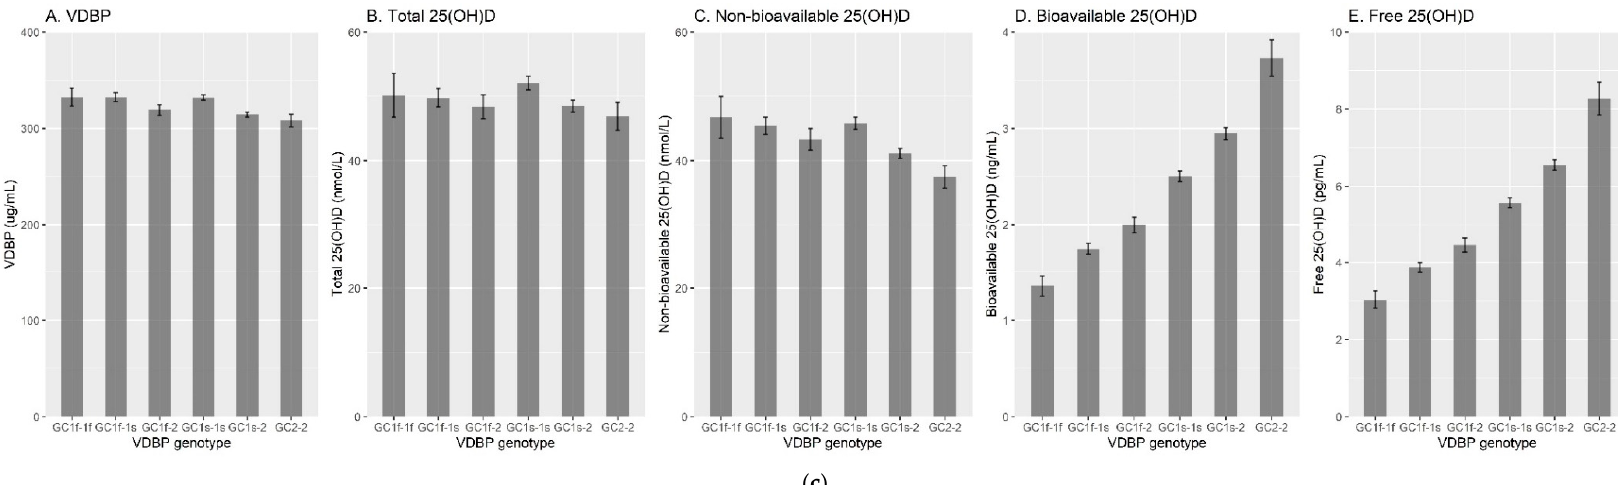
Figure 3. VDBP, total, non-bioavailable, bioavailable, and free 25(OH)D concentrations by season and month of blood draw, and VDBP genotype. ( a ) By season of blood draw (spring: March, April, and May; summer: June, July, and August; autumn: September, October, and November; winter: December, January, and February). ( b ) By month of blood draw. ( c ) By VDBP genotype. Abbreviations: VDBP: vitamin D binding protein.